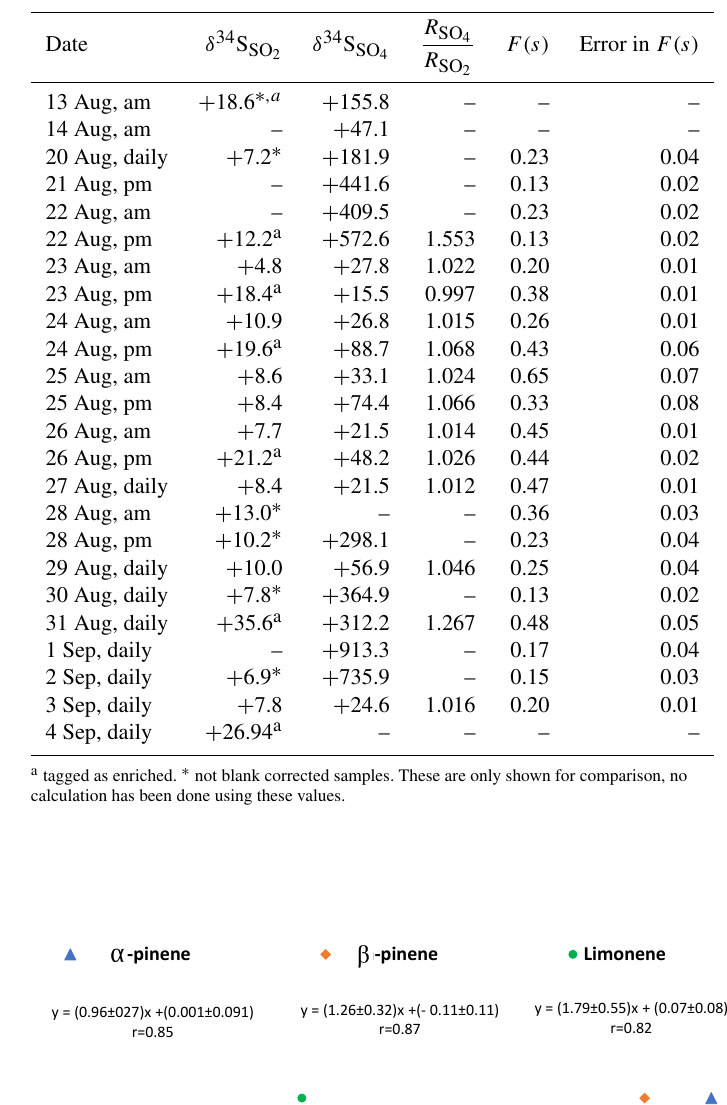
Table 2. δ 34 S values (‰) for SO 2 and sulfate with diameter D < 0 . 49µm, ratio of sulfate to SO 2 isotope during CIMS-ON periods, F(s) values, and the error in F(s) . Enriched samples were selected by comparing the mass-dependent fractionation relation between δ 34 S and δ 33 S for the sample and standards at the same run. Average uncertainty for δ 34 S values is ± 0.5‰.